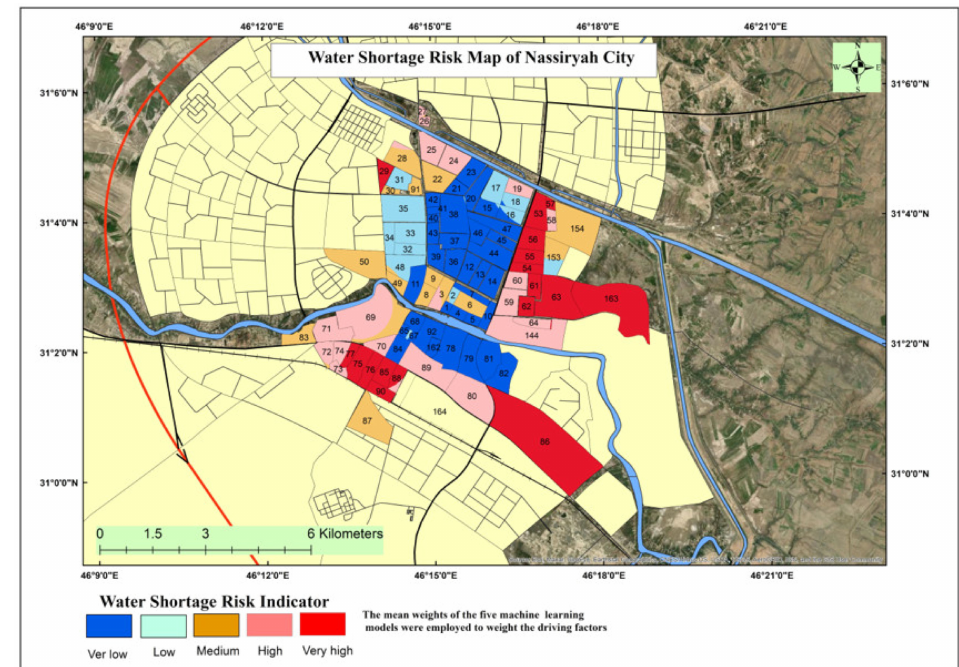
Figure 11. Final WSR map classified into five categories (Very high, High, Medium, Low and Very low).